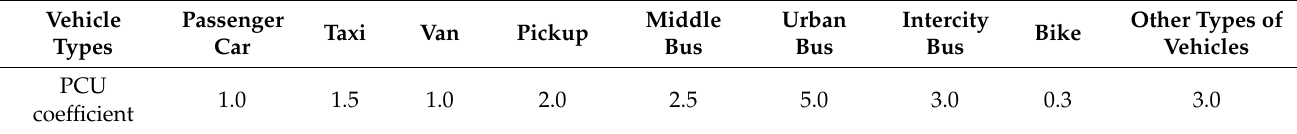
Table 3. Adopted passenger car units (PCU)